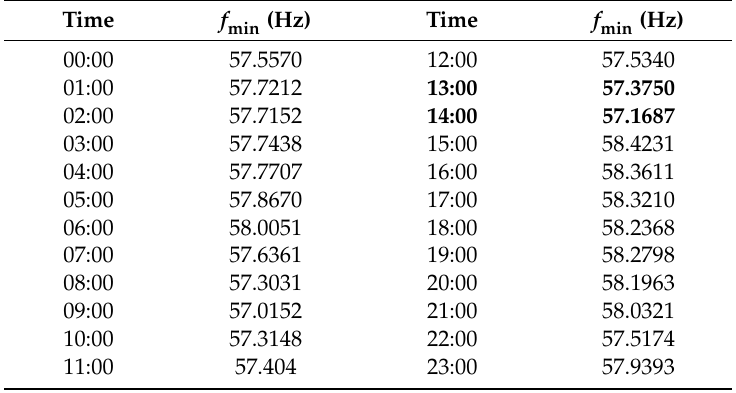
Table 5. The predicted frequency nadir without the proposed